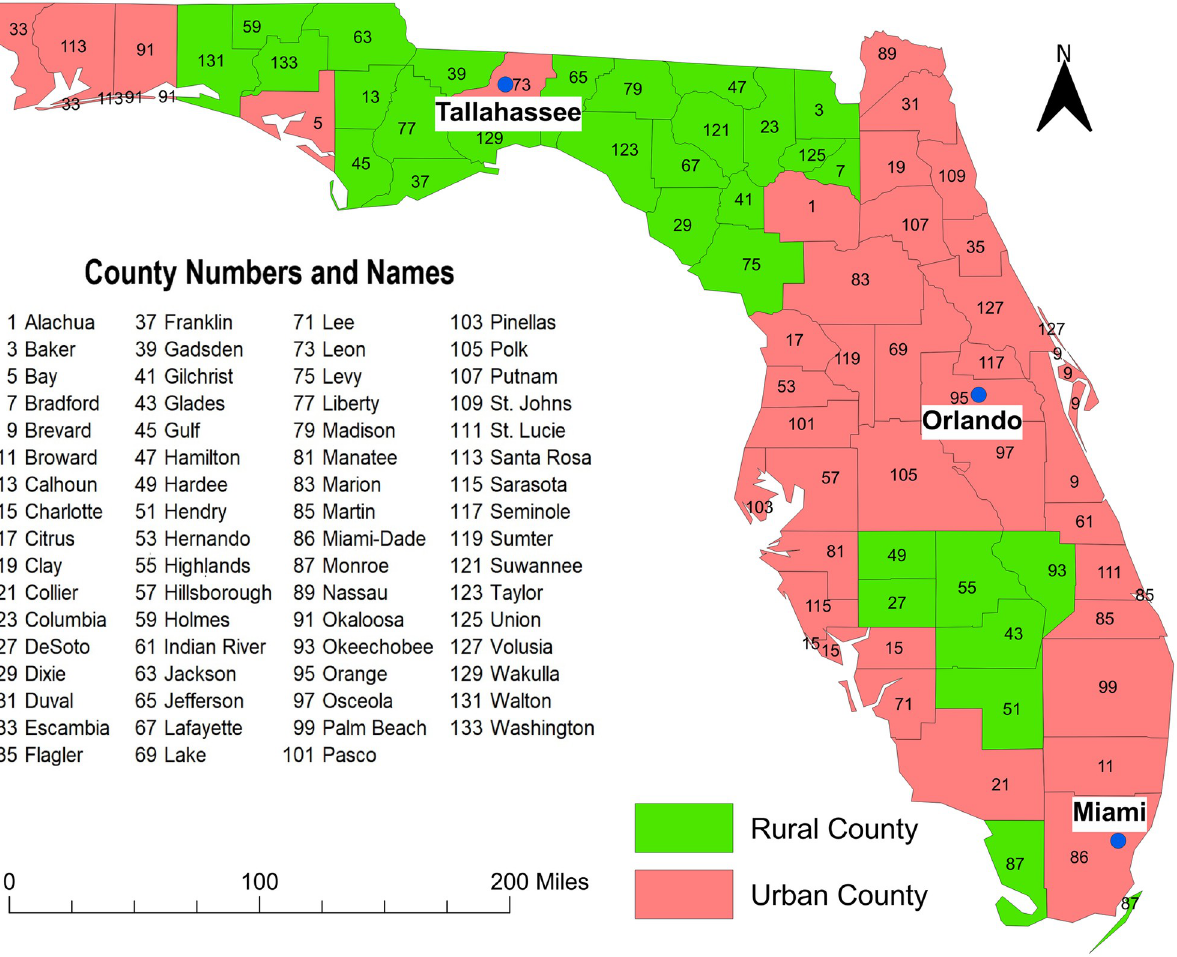
Fig 1. Map of Florida showing geographic distribution of urban and rural counties. Figure was created using the Free and Open Source Geographic Information System (GIS) software, QGIS. The basemaps used to create the maps were downloaded from the US Census Bureau Website: https://www. census.gov/geographies/mapping-files/time-series/geo/tiger-line-file.2010.html. The source of the data displayed in the map is Florida Department of Health. Data are available at: http://www.floridahealth.gov/programs-and-services/community-health/rural-health/_documents/rual-counties-2000-